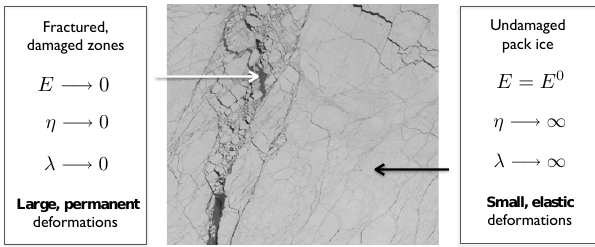
Figure 3. Dependence of the apparent viscosity ( η ), of the elastic modulus ( E ) and of the relaxation time ( λ ) on the level of damage in the Maxwell-EB sea ice model. The image is a SPOT satellite aerial picture of a 59km × 59km portion of the Arctic sea ice cover centred around 80.18 ◦ N, 108.55 ◦